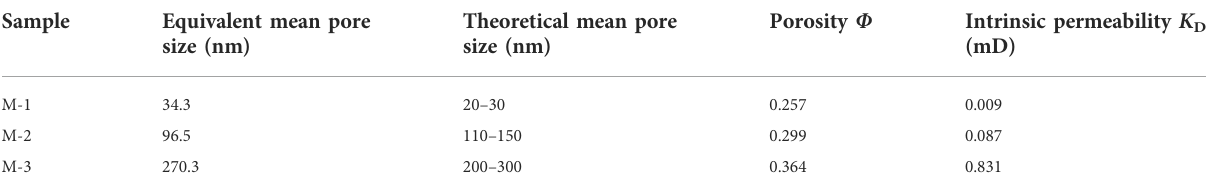
TABLE 1 Pore parameters of the membranes.